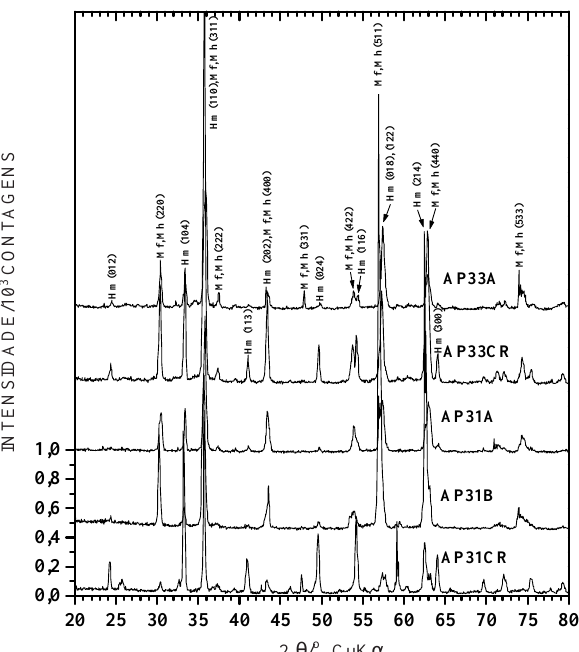
Figura 3. Difratogramas de Raios X (método do pó) das amostras dos concentrados magnéticos das frações areia. Mf = magnesioferrita, Mh = maghemita e Hm = hematita.